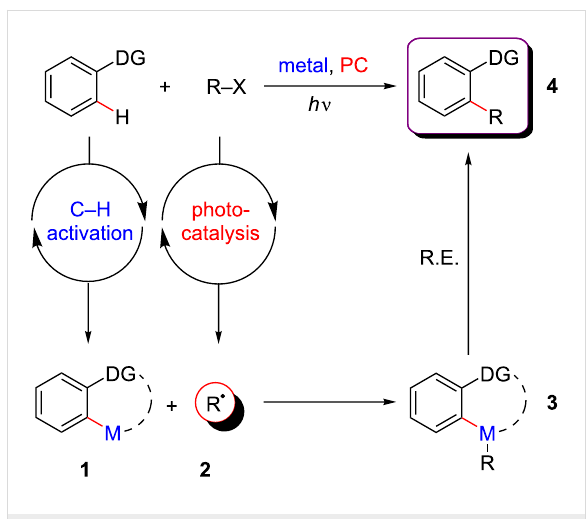
Figure 19: General concept of dual catalysis merging C–H activation and photoredox